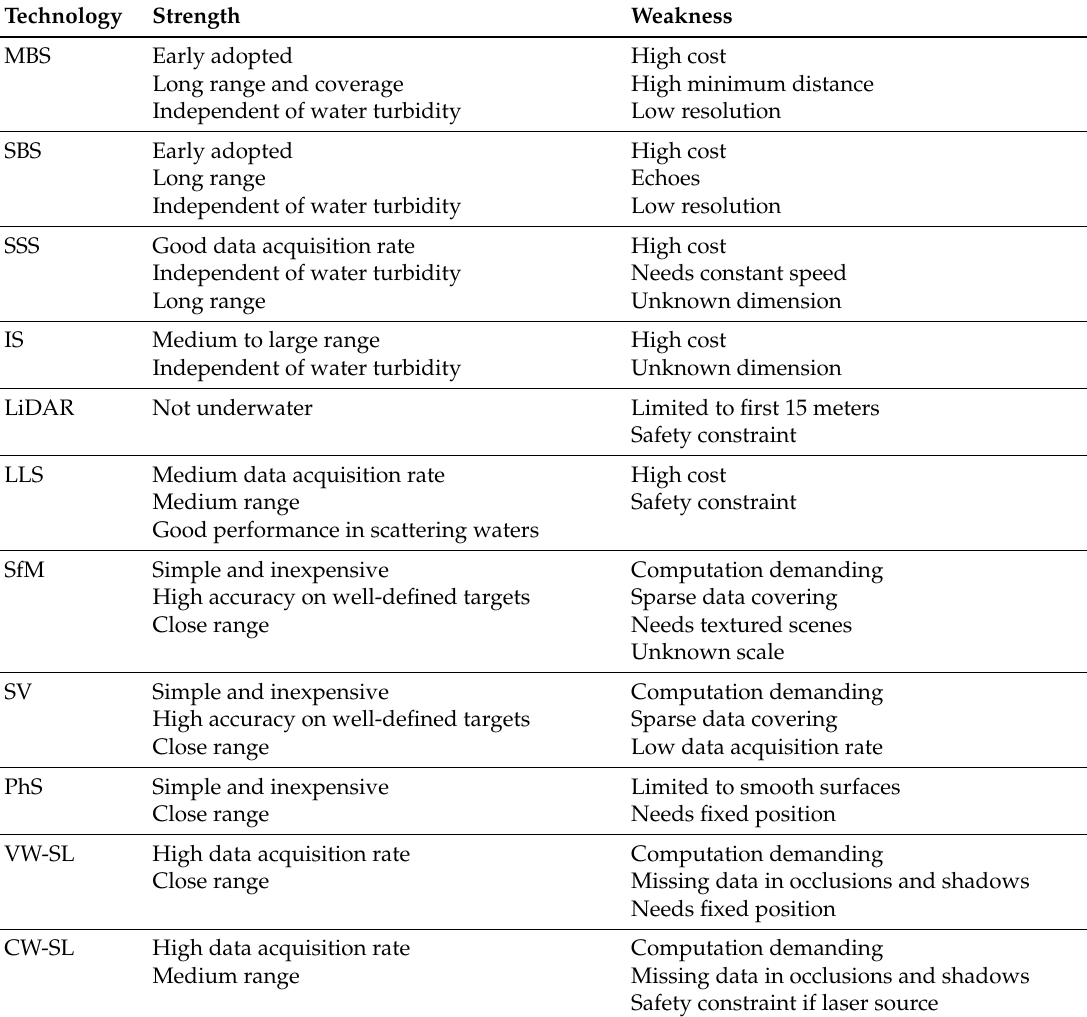
Table 9. Strengths and weaknesses of the sensors and techniques for 3D